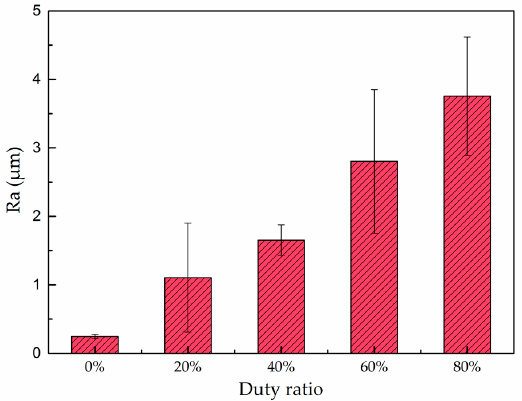
Figure 3. The surface roughness of the polished copper plate and the as-coated surfaces deposited at 30 V and 1000 Hz pulse current for different duty ratios.